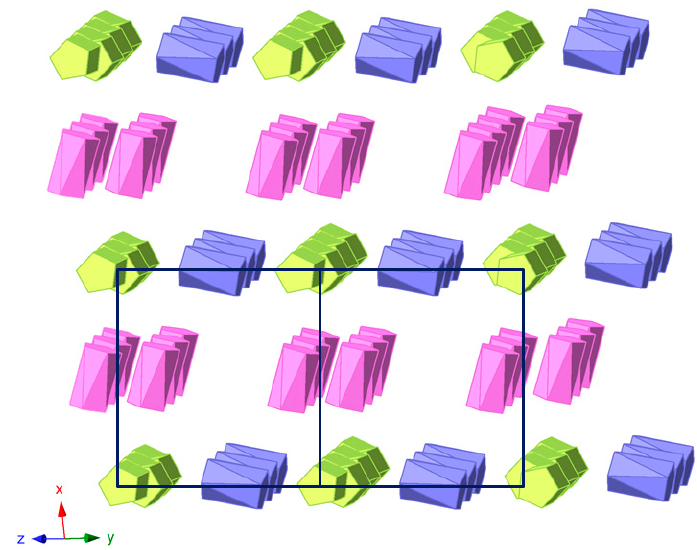
Figure 6. View of the organometallic sub-lattice formed by π - π interactions between ferrocenyl units in 1 along the [011] direction. Colour code: Fe1 ferrocenium (green), Fe2 ferrocenium (pink), Fe3 ferrocene (blue). Table 3. Bond lengths (Å) and angles (°) for C–H···O type interactions in 1 .